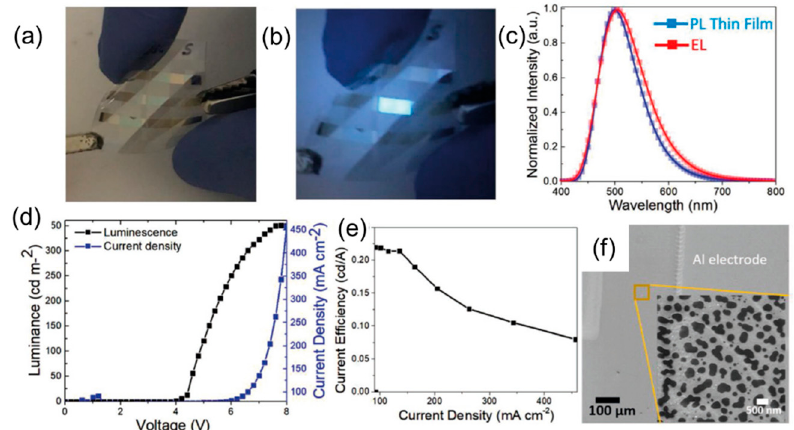
Figure 19. Picture of a flexible device: ( a ) off mode and ( b ) on mode; ( c ) the normalized EL spectra of the device and solid-state PL of a thin film; ( d ) J-L-V characteristic of the device; ( e ) current efficiency versus current density; and ( f ) CD 2D islands in the emitter layer: Reproduced with permission from [79], copyright 2020 Wiley-VCH Verlag GmbH & Co.